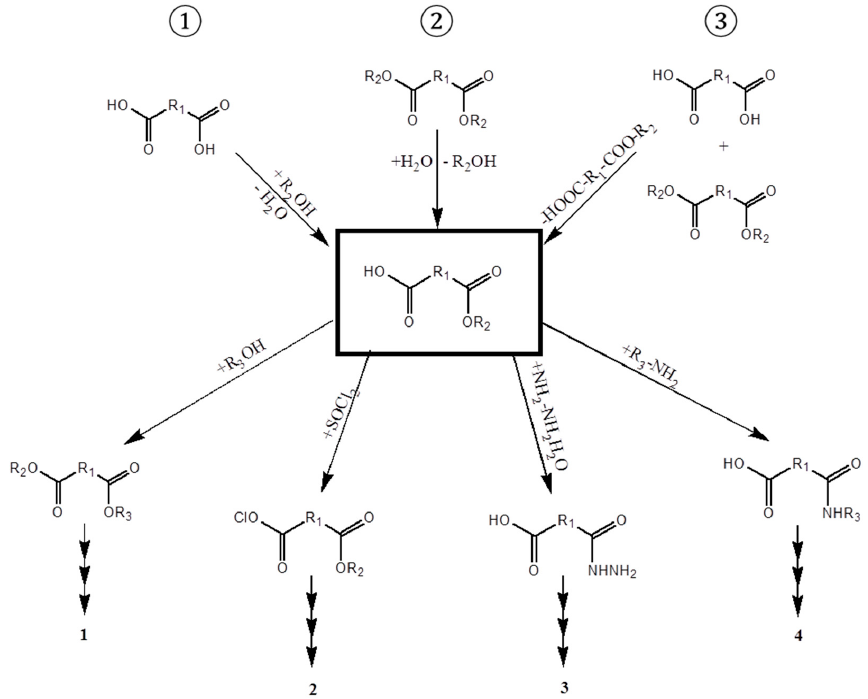
Figure 1. Synthesis of aliphatic monoesters by esterification, selective monohydrolysis, and trans- esterification, and the following reactions for which monoesters are used [7–13]. 1, 2, 3 and 4 are described in Table 1. Table 1. Substances produced from monoesters.